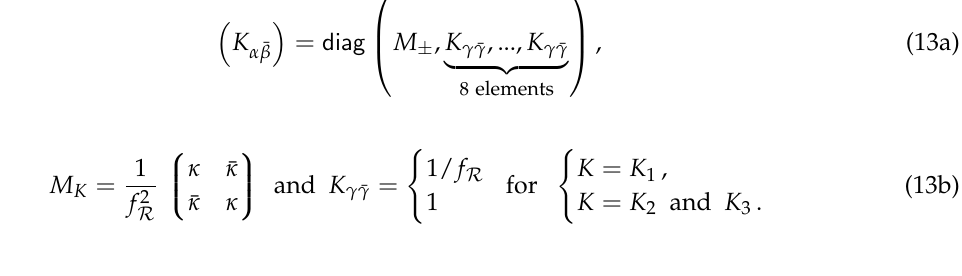
0.03, and n = 0.1, − ± (cid:39) 10 − 3 (light ×